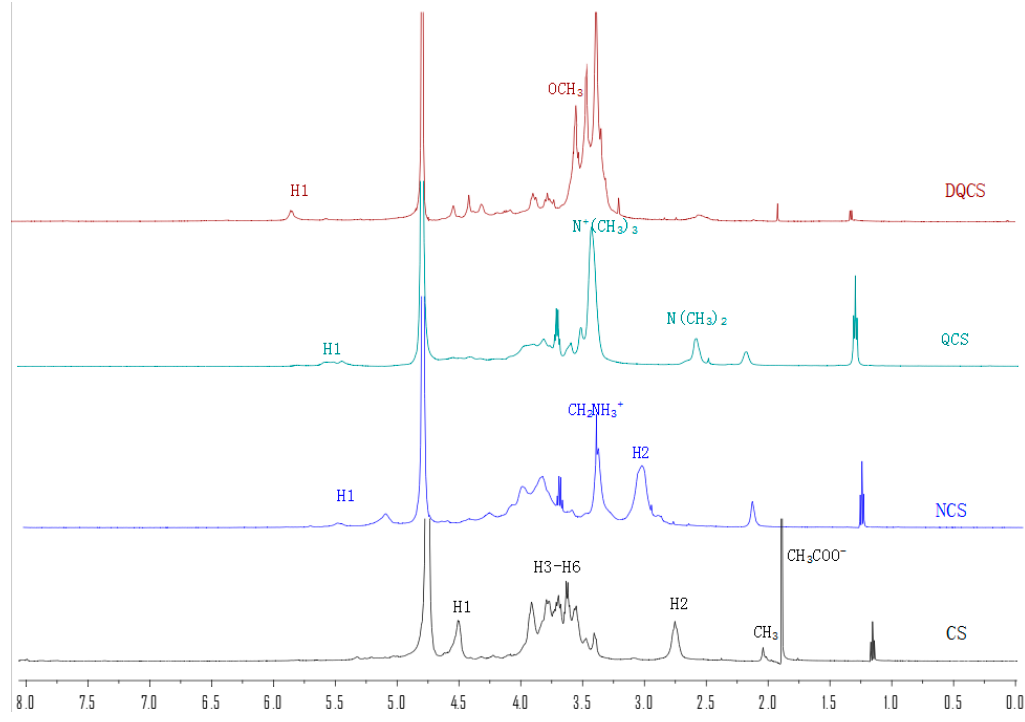
Figure 2. 1 H NMR spectra of chitosan derivatives.